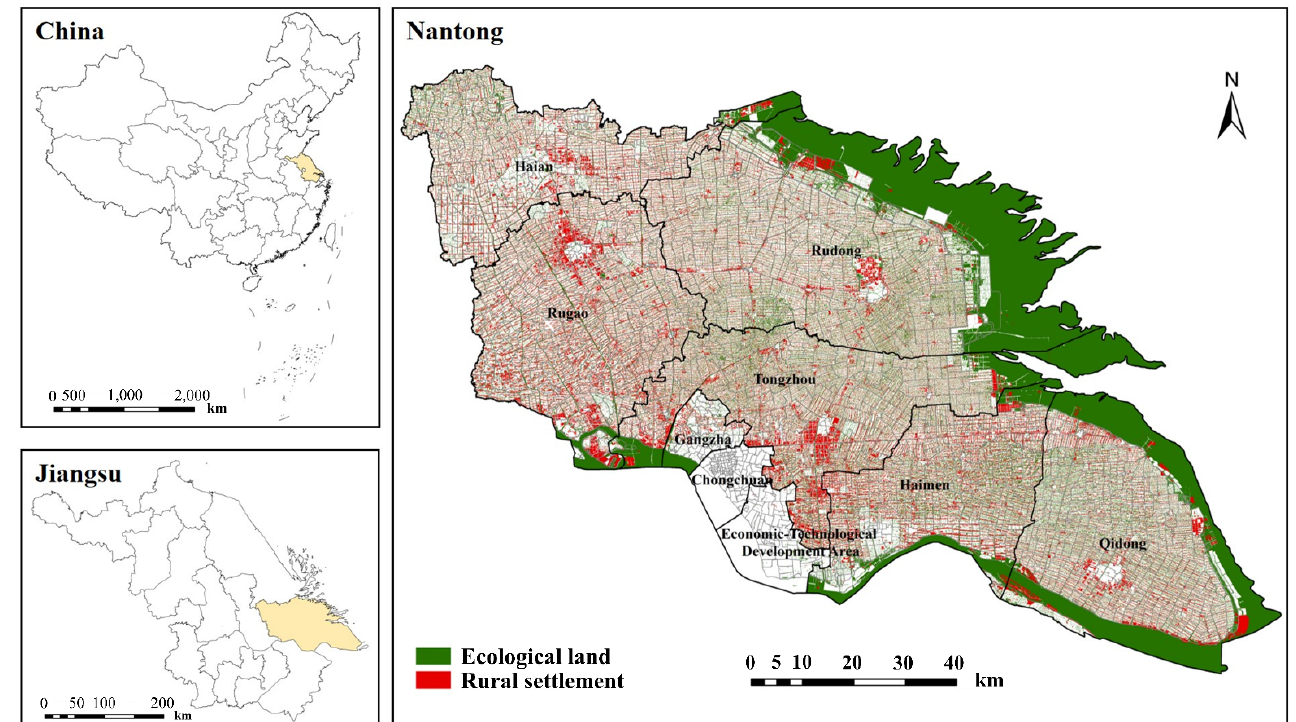
Figure 1. Distribution of ecological land and rural settlements in Nantong. Compared with the occupation of ecological land by urban construction land, RSEEL is more implicit. The area of ecological land in Nantong decreased from year to year, from 3618.72 km 2 to 3402.85 km 2 , during the 2009–2018 period, with an average annual reduction of 23.99 km 2 . However, rural settlements in Nantong expanded continuously, and the settled areas increased by 8.55%, from 1295.60 km 2 to 1406.34 km 2 , during the 2009-period (Figure 2). The area of per capita rural settlement land in Nantong is 192.12 m 2 , which is beyond the national standard of 150 m 2 . The expansion of rural settlements